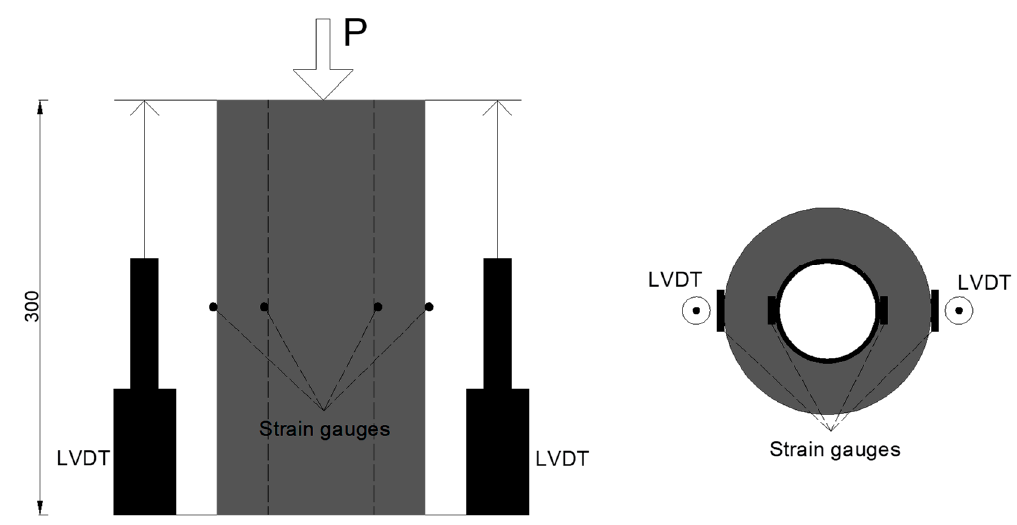
Figure 4. Locations of LVDTs and strain gauges.